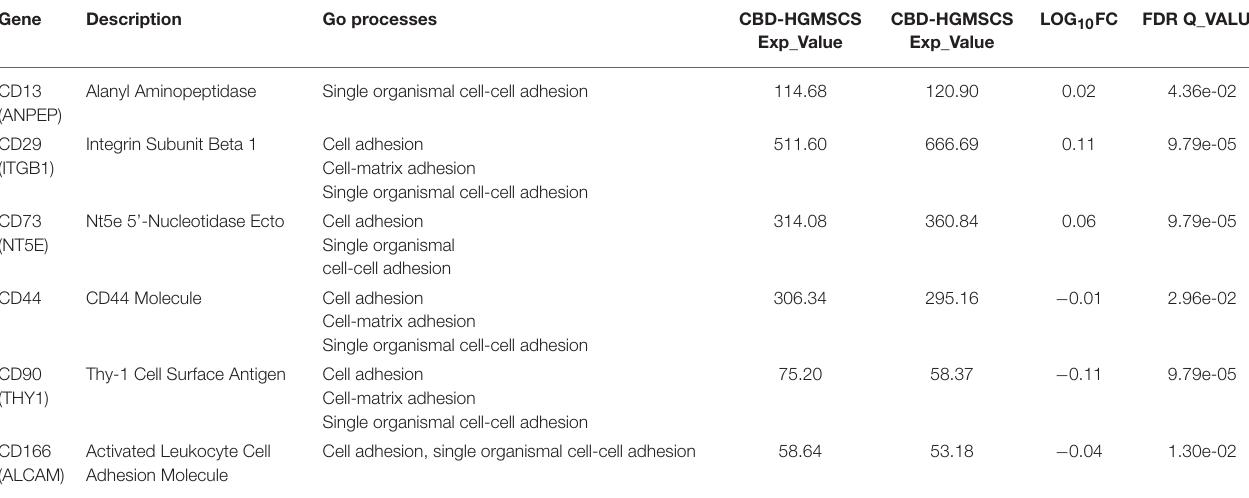
TABLE 4 | Mesenchymal markers differentially expressed between CTR-hGMSCs and CBD-hGMSCs. Gene